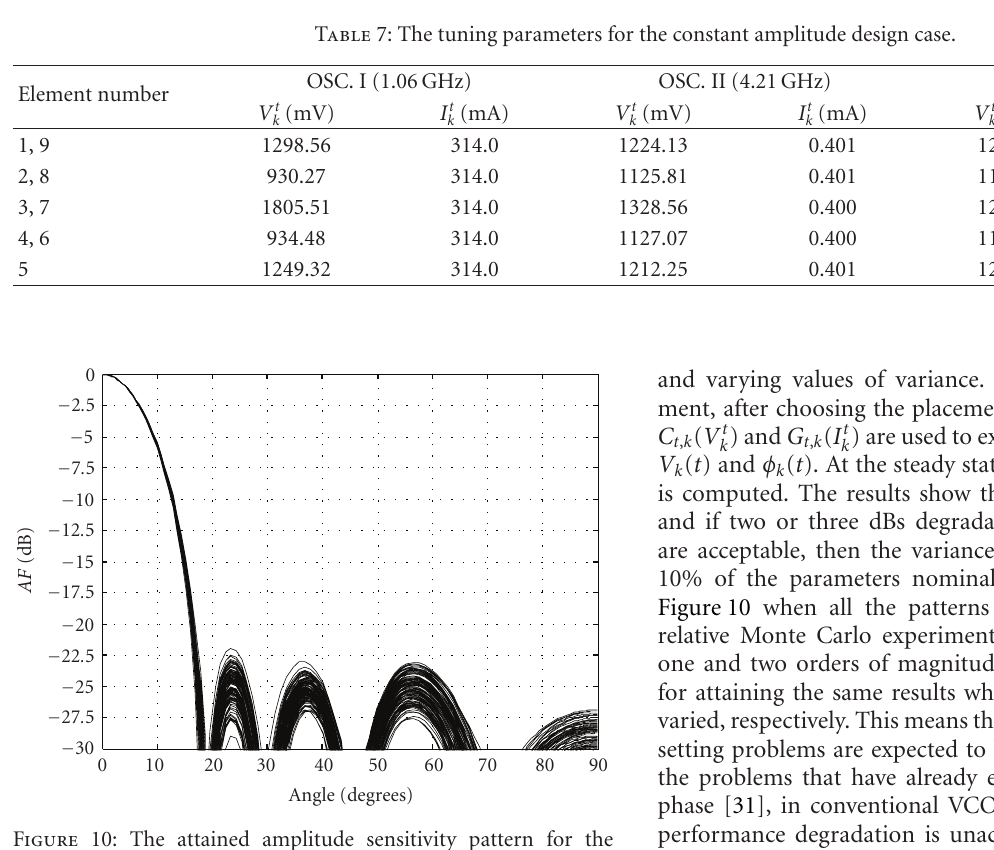
Figure 10: The attained amplitude sensitivity pattern for the general design